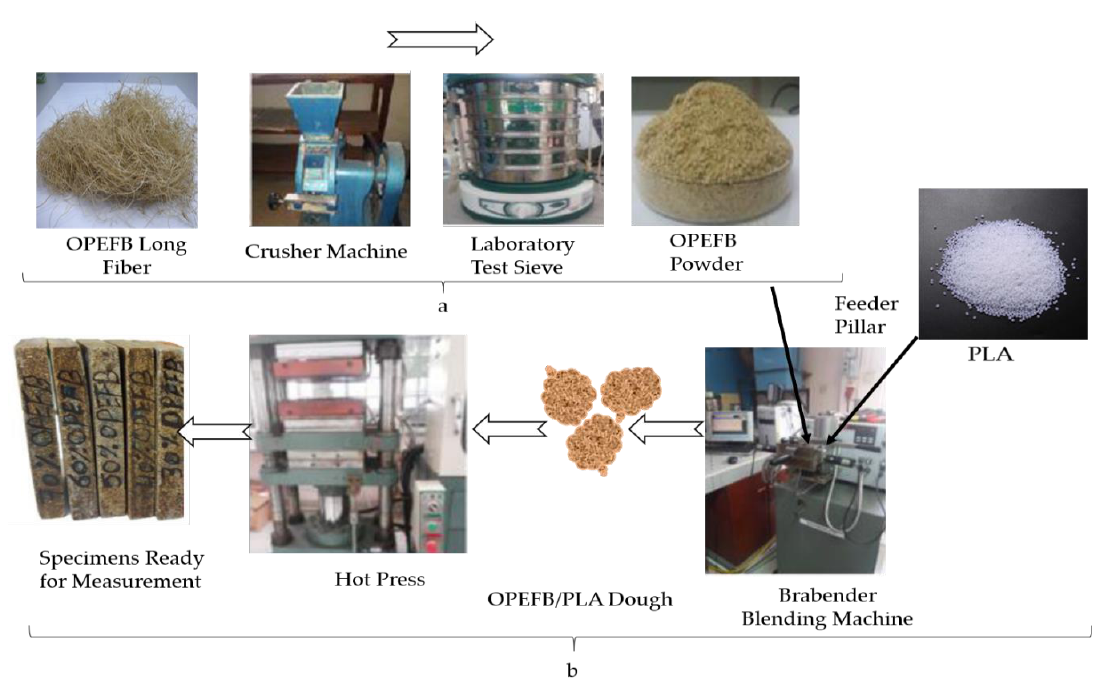
Figure 3. ( a ) Preparation process of OPEFB powder, and ( b ) OPEFB/PLA substrate preparation.